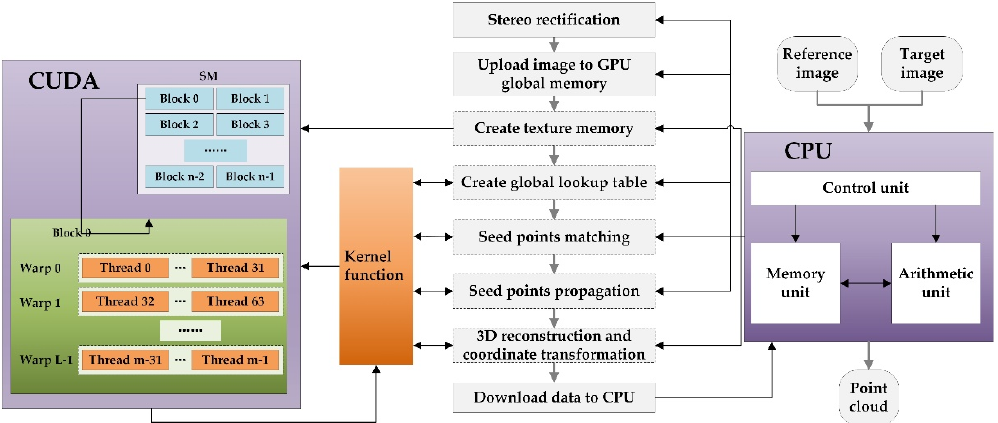
Figure 5. Schematic diagram of CUDA-based serial-parallel computing strategy.